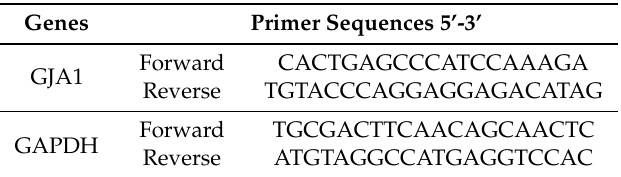
Table 3. Gene primers used for RT-PCR and real-time